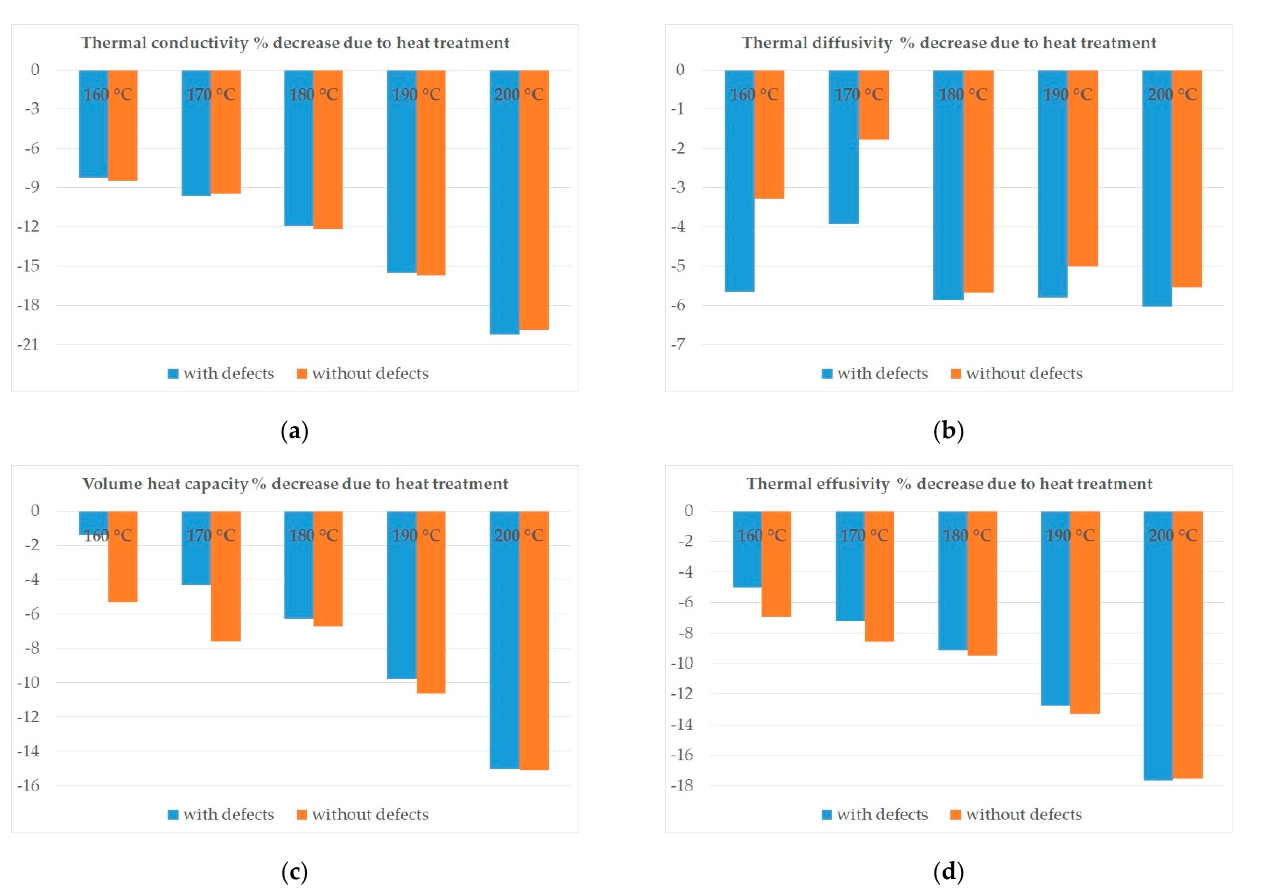
Figure 8. Demonstration of the identification of a knot inside a test sample and its exact position (range) through volume rendering technique.